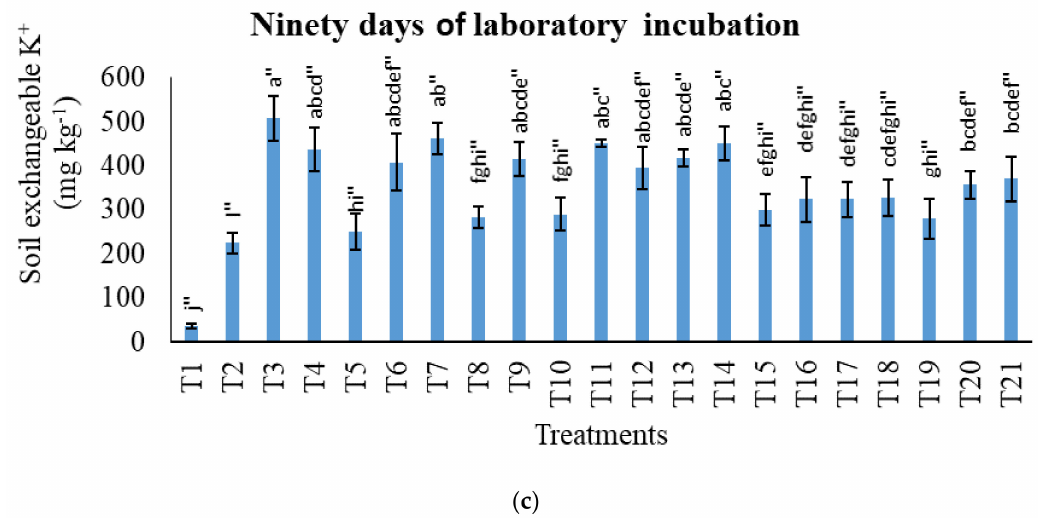
Figure 13. Effects of treatments on soil-exchangeable potassium over ( a ) thirty; ( b ) sixty; and ( c ) ninety days after incubation. T1: soil control, T2: conventional practice, T3: muriate of potash + 100% charcoal + 100% sago bark ash, T4: muriate of potash + 100% sago bark ash, T5: muriate of potash + 100% charcoal, T6: muriate of potash + 80% charcoal + 80% sago bark ash, T7: muriate of potash + 60% charcoal + 80% sago bark ash, T8: muriate of potash + 40% + 80% sago bark ash, T9: muriate of potash + 20% charcoal + 80% sago bark ash, T10: muriate of potash + 80 charcoal + 60% sago bark ash, T11: muriate of potash + 60% charcoal + 60% sago bark ash, T12: muriate of potash + 40% charcoal + 60% sago bark ash, T13: muriate of potash + 20% charcoal + 60% sago bark ash, T14: muriate of potash + 80% charcoal + 40% sago bark ash, T15: muriate of potash + 60% charcoal + 40% sago bark ash, T16: muriate of potash + 40% charcoal + 40% sago bark ash, T17: muriate of potash + 20% charcoal + 40% sago bark ash, T18: muriate of potash + 80% charcoal + 20% sago bark ash, T19: muriate of potash + 60% charcoal + 20% sago bark ash, T20: muriate of potash + 40% charcoal + 20% sago bark ash, and T21: muriate of potash + 20% charcoal + 20% sago bark ash. Different letters indicate significant differences between means using Tukey’s HSD test at p ≤ 0.05. The error bars are the ± standard error of triplicates. Letters without any marks and letters with ‘ and ” indicate mean comparison within thirty, sixty, and ninety days after incubation,